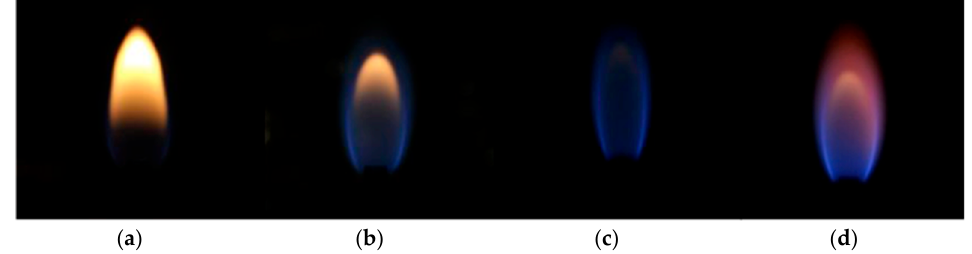
Figure 7. Methane/air laminar jet diffusion flame. Jet diameter was 2 mm, and methane flow rate was Figure 7. Methane / air laminar jet di ff usion flame. Jet diameter was 2 mm, and methane flow rate was 65 mL/min with air coflowing 1 L/min. The figure shows the evolution of the flame with water 65 mL / min with air coflowing 1 L / min. The figure shows the evolution of the flame with water addition; addition; ( a ) no water added; ( b ) 0.25 water/methane molar ratio; ( c ) 0.55 water/methane molar ratio; ( a ) no water added; ( b ) 0.25 water / methane molar ratio; ( c ) 0.55 water / methane molar ratio; ( d ) flame at ( d ) flame at the extinction limit (0.57 water/methane molar ratio). the extinction limit (0.57 water / methane molar ratio).